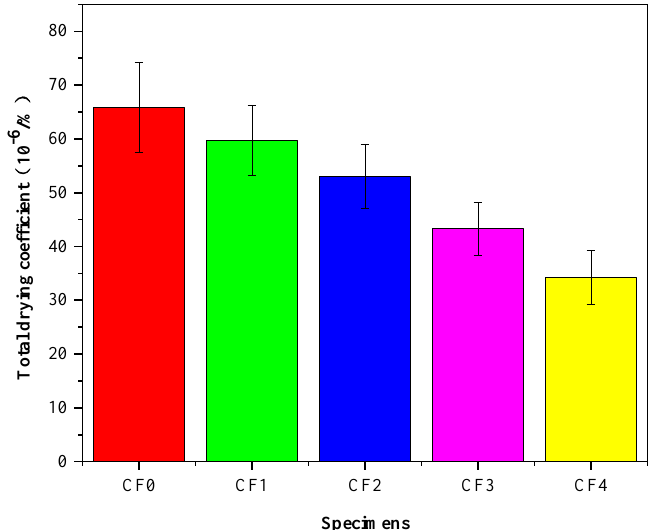
Figure 6. Total drying shrinkage coefficient of CSM with 100% RMA under different fly ash replace-